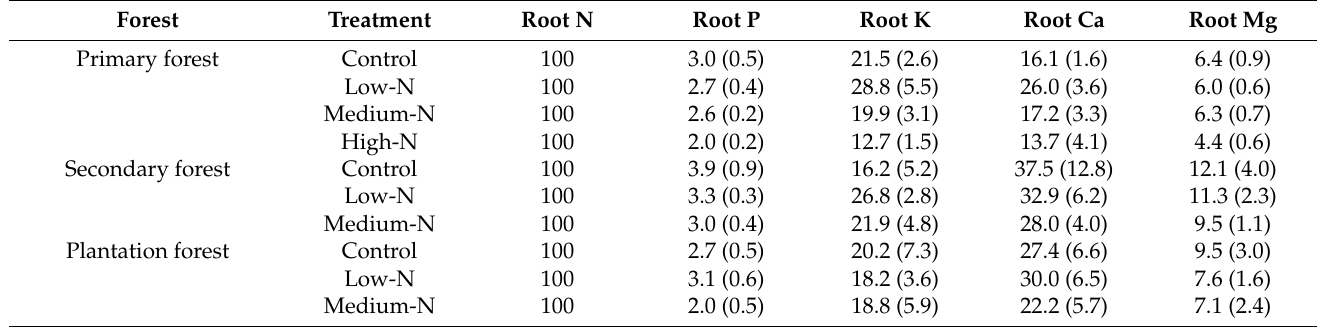
Table A1. Nutrient weight proportions (N = 100) in living fine roots (<2 mm in diameter) in the 0–10 cm depth of mineral soil in the three forests in Dinghushan in southern China. According to Ingestad (1979), the optimum weight proportions are 100 N:15 P:45 K:6 Ca:6 Mg for Picea abies